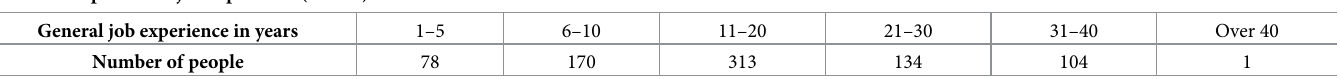
Table 3. Respondents’ job experience (N = 80).